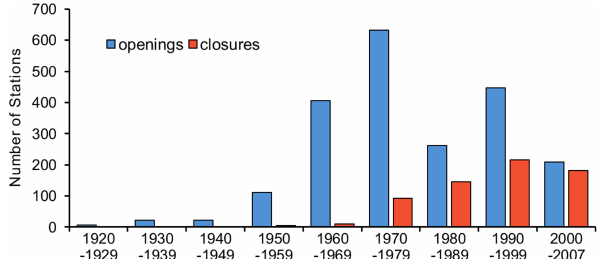
Figure 6. Evolution of the England and Wales stream gauging net- work. Number of gauging station openings and closures per decade (re-drawn from Hannaford et al.,